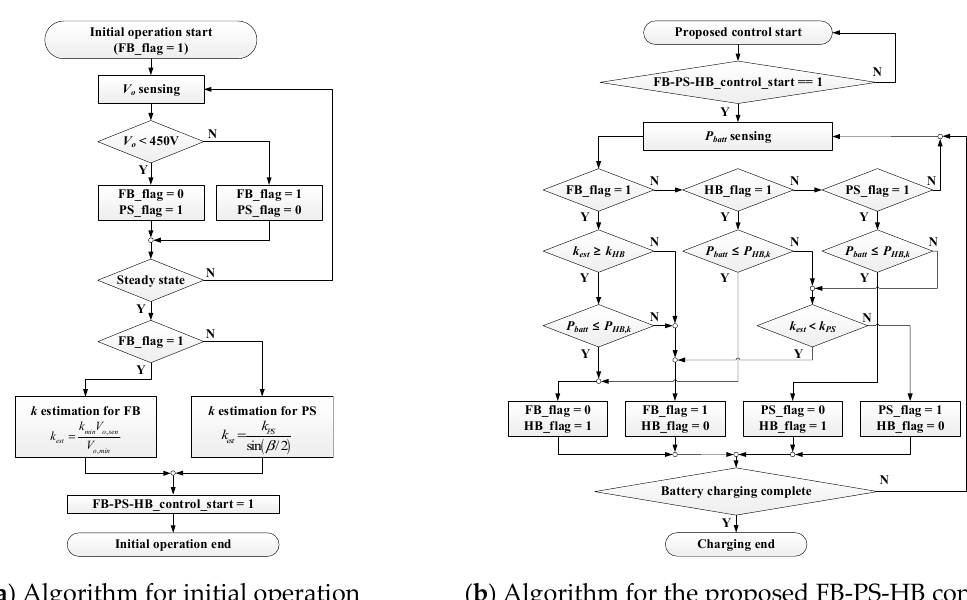
( b ) Algorithm for the proposed FB-PS-HB control Figure 6. Flow charts of the proposed control algorithm.